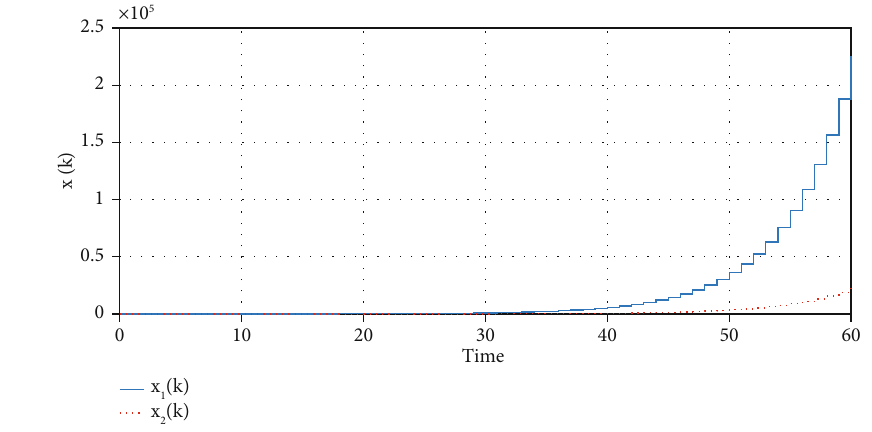
Figure 5: State response of the second subsystem.